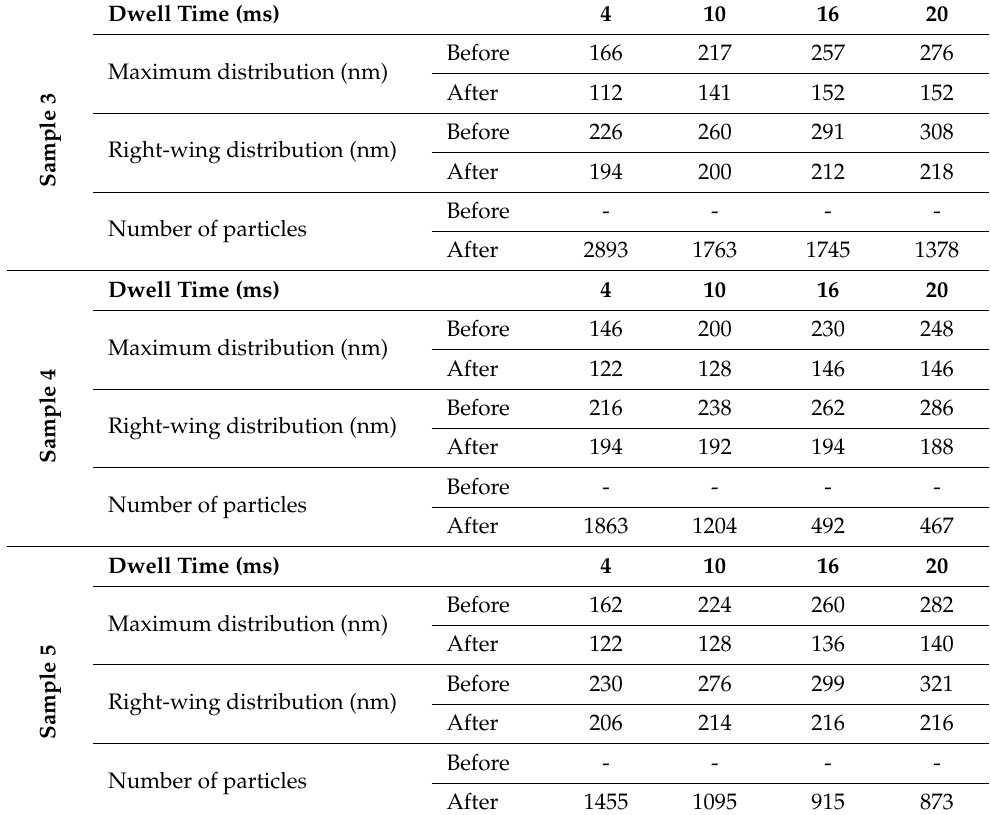
Table 1. Change in characteristics of TiO 2 NP size distributions of cosmetic product samples after background signal